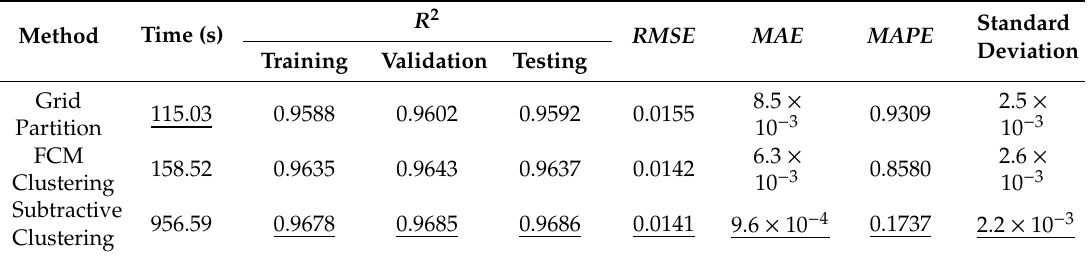
Table 1. Analysis with di ff erent fuzzy inference structures. FCM: fuzzy c-means clustering method; RMSE: root mean square error.